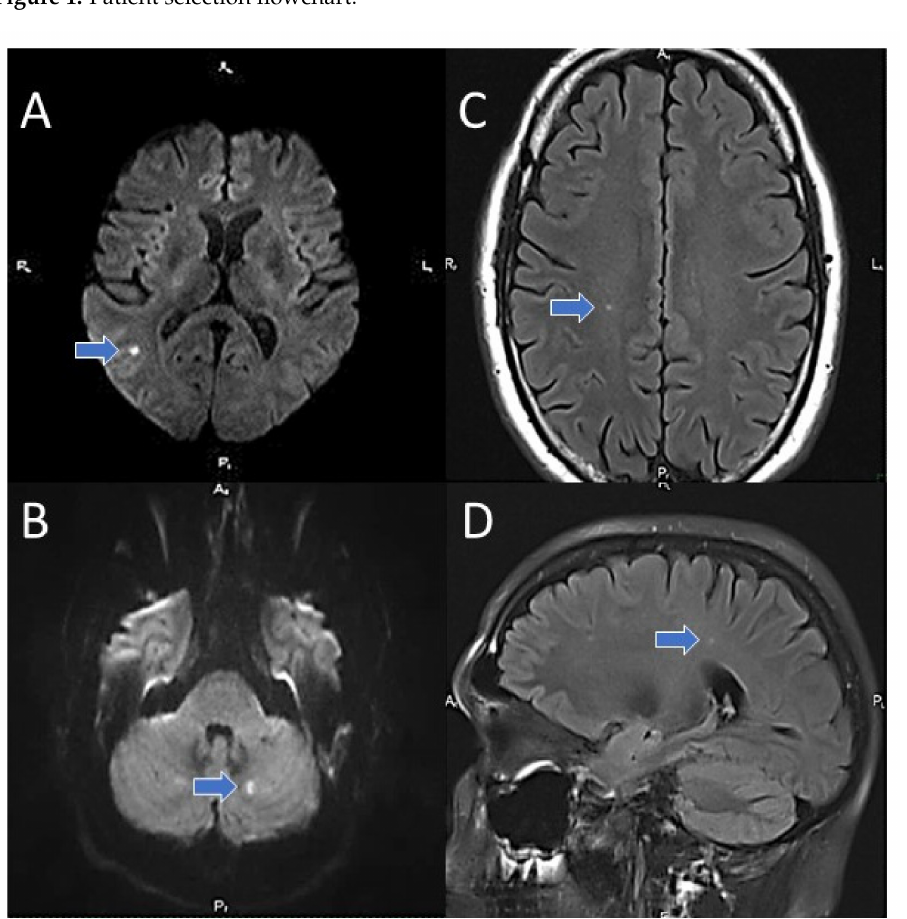
Figure 2. Covert brain infarcts in patients of the study group (MRI). ( A , B )–DWI; ( C , D )–T2